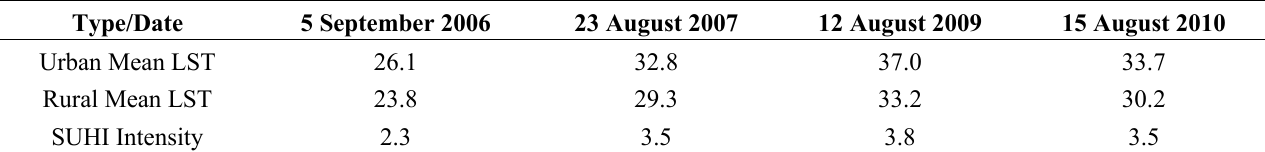
Table 7. Estimated SUHI intensities (in °C) derived from Landsat TM